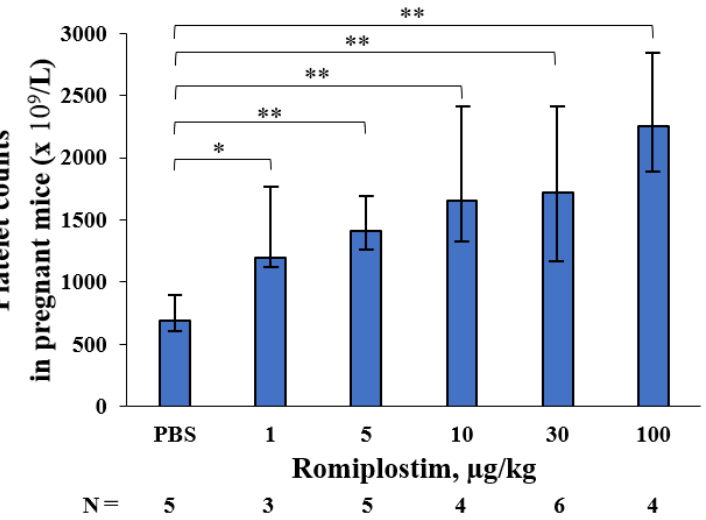
and VEGF-B also did not show significant changes (Figure 5D).